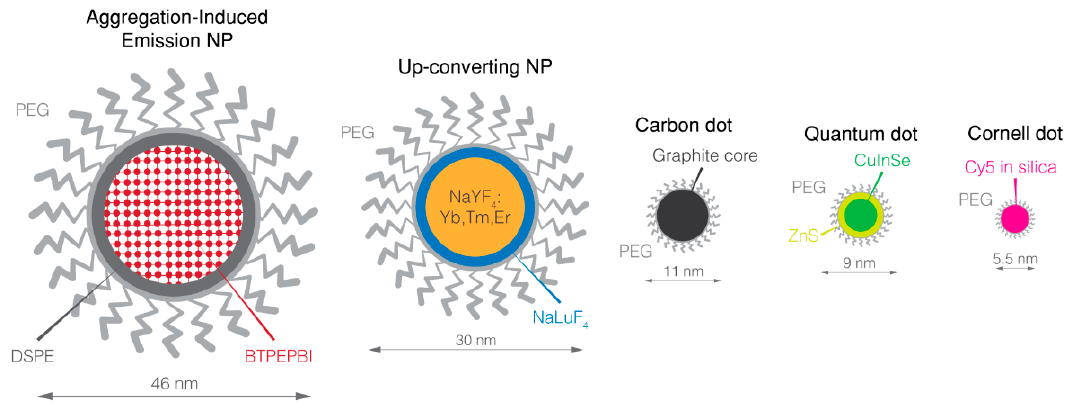
Figure 1. Overview of NIR nanoparticles. BTPEPBI: 1,7-tetraphenylethene modified 3,4:9,10-Tetracarboxylic perylene bisimide; Cy5: cyanine 5; DSPE: 1,2-distearoyl- sn -glycero-3-phosphoethanolamine- N - [amino(polyethylene glycol)]; NP: nanoparticle; PEG: